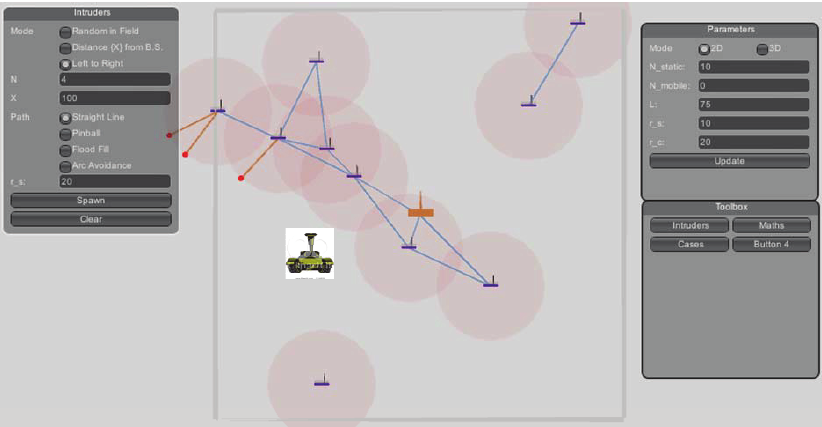
Figure 4. A screenshot of the simulator using the Unity platform.